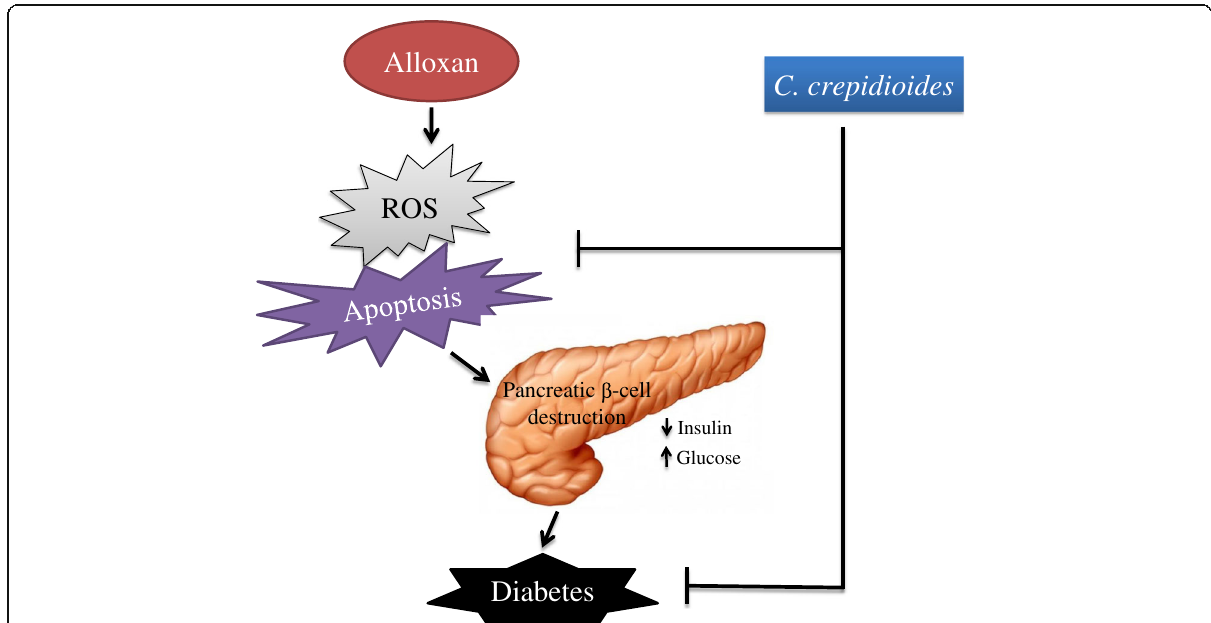
Fig. 10 Proposed mechanism of β -cell protection and antidiabetic activities of C. crepidioides against alloxan-induced oxidative stress. The schematic diagram showing the proposed mechanism underlying the β -cell protection and antidiabetic effect of C. crepidioides against the alloxan-induced ROS production, apoptotic degeneration and pancreatic